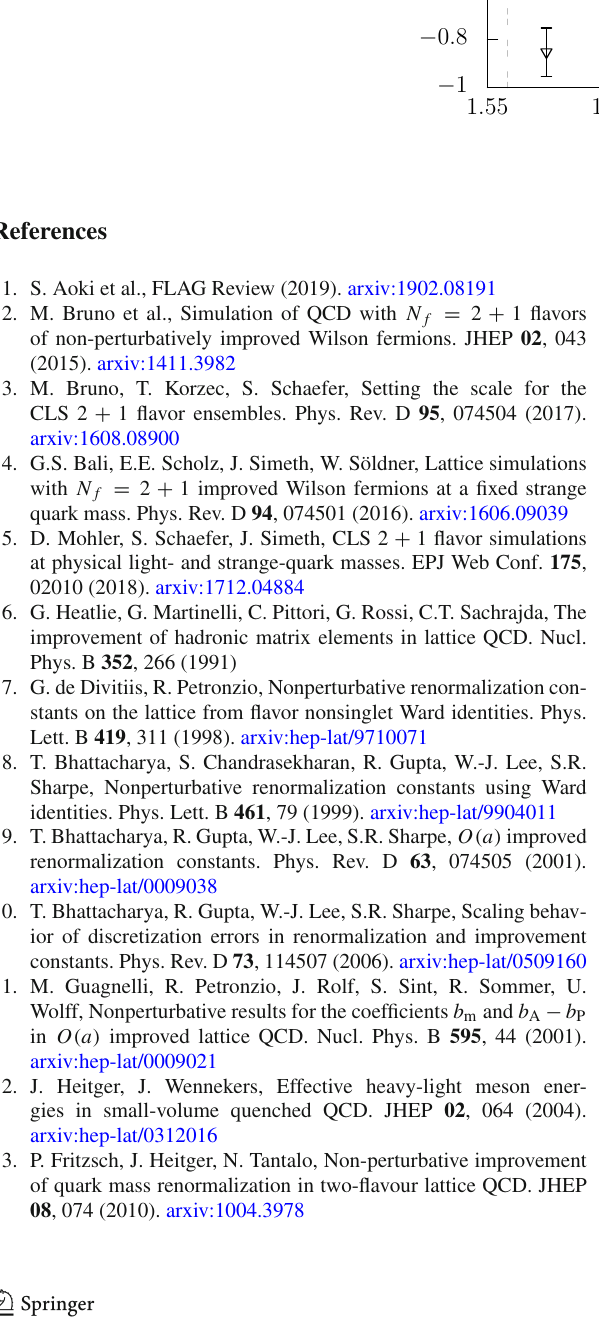
81 60 . 40 . 20 . 200 . corr m − 0 . − 0 . 4 − 0 . 6 − 0 . 8 − 1